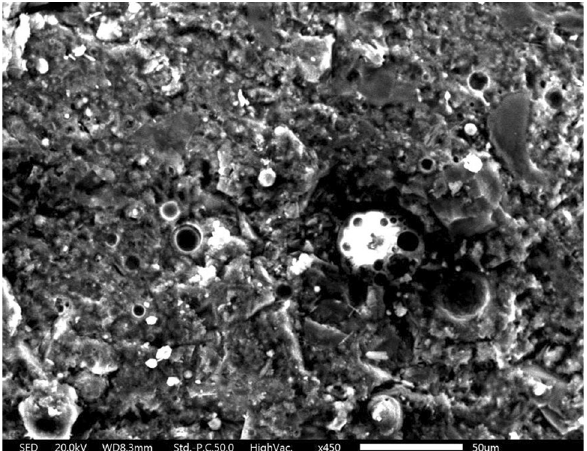
Fig. 9 Randomly distributed unreacted fly ash shown as hollow spherical particles in the 40FA cement paste.